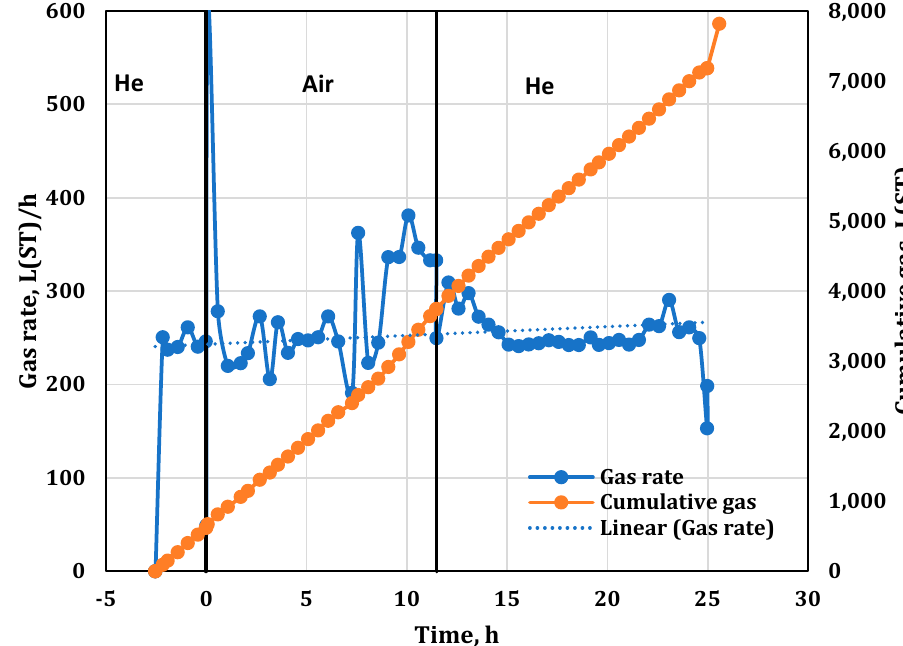
Figure 11. WTM-measured results: cumulative gas production and produced gas